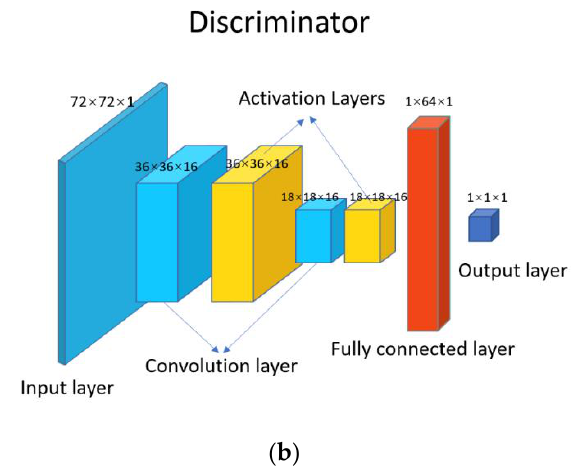
Figure 1. The proposed generator and discriminator of the DCGAN in this work. For the generator structure of the DCGAN designed in this work, the input dimen- sion was 18 × 18 × 1 after the normalization process, the output dimension was 72 × 72 × 1 , and 𝑡𝑎𝑛ℎ(∙) was used as the activation function. The mechanism of the gen- erator is to recover the global grid points in a dimension of 72 × 72 , the same dimension as the original input before downsampling. The dimension input in the discriminator was 72 × 72 × 1 , and the discriminator had two inputs: fake data from the generator and the original GIM TEC. It had one binary output to represent true or false, where 1 represented output data that were real, and 0 represented output data that were fake. Through the nally making the generator infinitely output approximately real data.